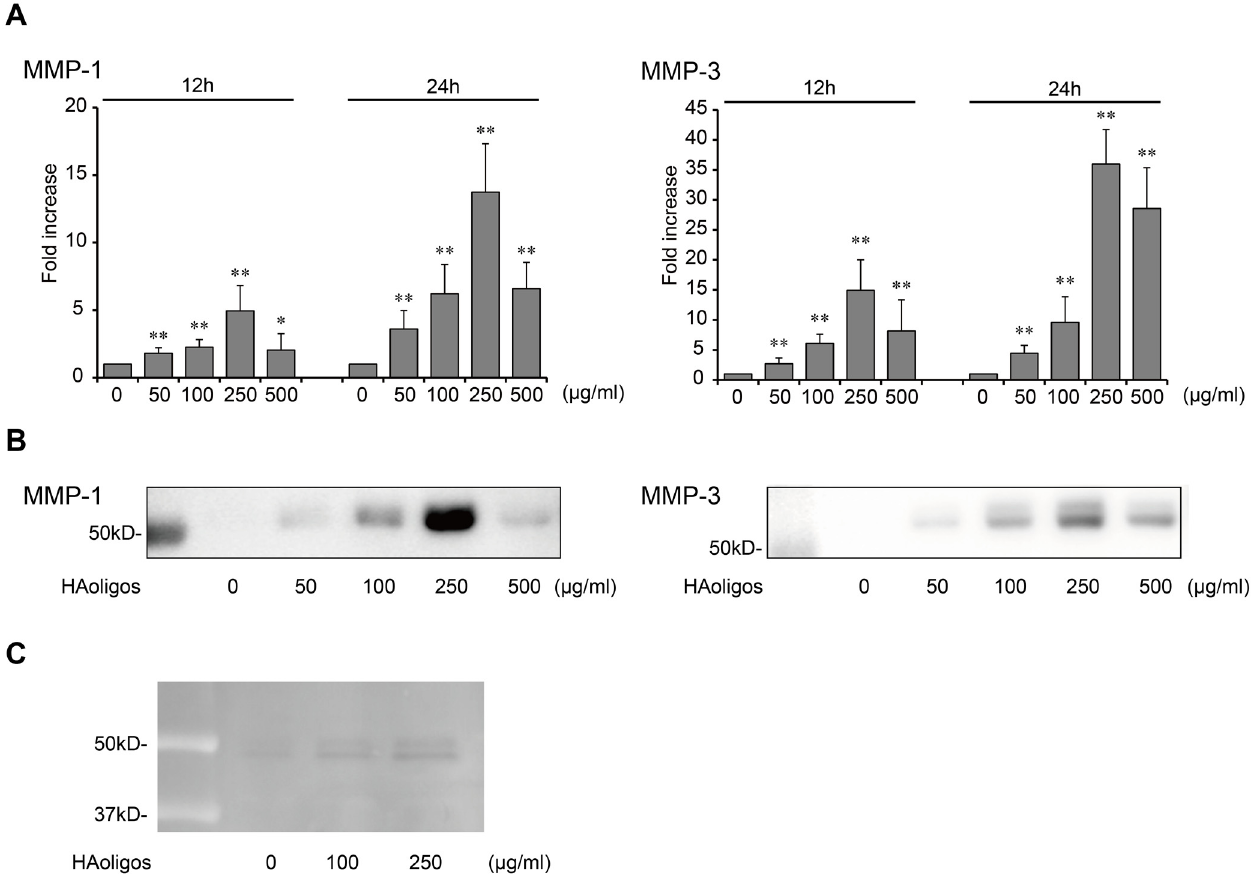
Fig 2. Expression levels of matrix metalloproteinase (MMP) mRNA and protein secretion induced by HAoligo treatment. RSFs were treated with various concentrations of HAoligos (0 – 500 μ g/ml). A , MMP-1 and MMP-3 mRNA expression levels after 12 or 24 hours of HAoligo treatment as detected by quantitative real-time RT-PCR. Results shown are fold change in mRNA copy number. Values are mean ± S.D. of three independent experiments analyzed in triplicate, and are expressed as n-fold increase compared to untreated control. * p < 0.05 and ** p < 0.01 vs. control. B , MMP-1 and MMP-3 protein secretion in conditioned media after 24 hours of HAoligo treatment as evaluated by immunoblot analysis. The amount of sample separated by SDS-PAGE before transfer and immunostaining was determined by the DNA content of RSFs. Results shown are representative of three experiments with similar results. C, The activity of MMPs secreted into conditioned media was evaluated by casein zymography. RSFs were stimulated with 0, 100, or 250 μ g/ml HAoligos for 24 hours. The image was digitally inverted to generate dark bands on a light